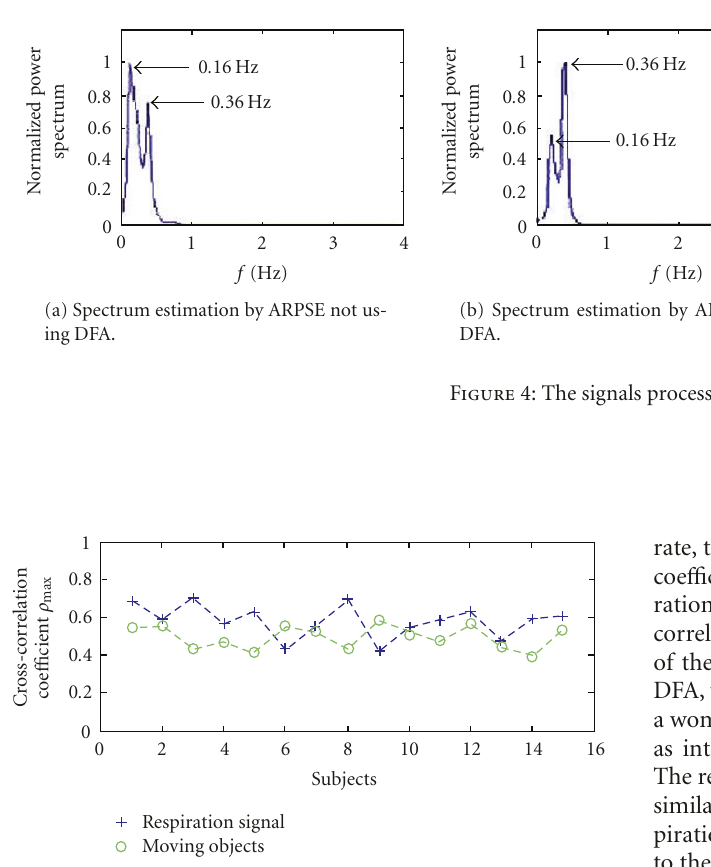
Figure 5: The distribution of the normalized cross-correlation co- e ffi cient ρ max